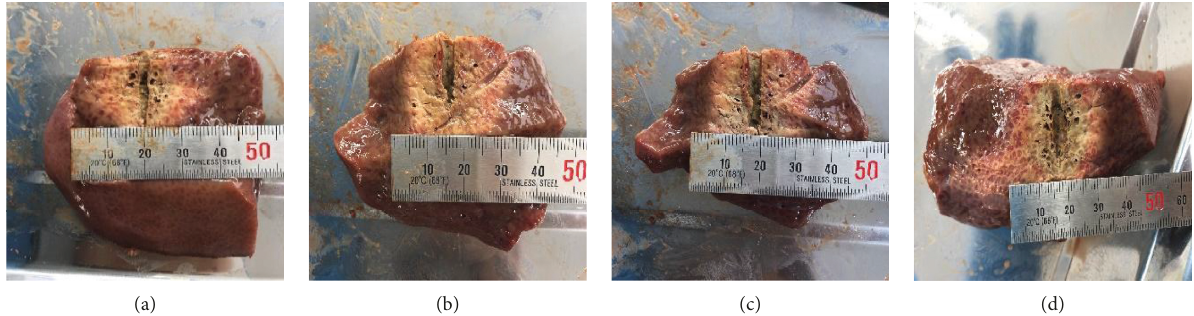
Figure 10: Experiment on the 4 different swine livers.